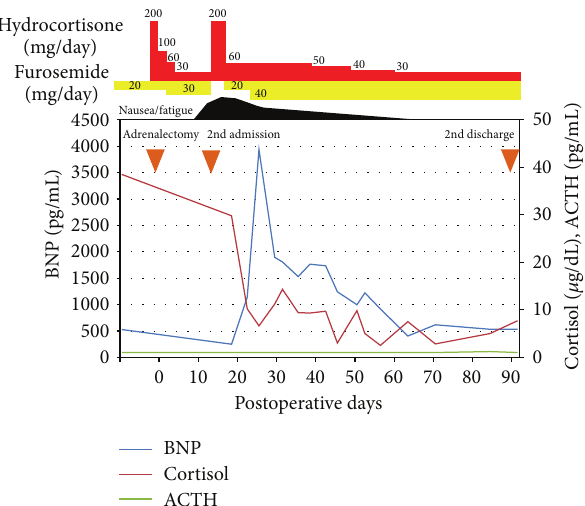
Figure2:Clinicalcourseofthepatientaftertheoperation.Thebrain natriuretic peptide (BNP) level (blue line) is shown on the left side. The levels of cortisol (red line) and ACTH (green line) are shown on the right side. The dosages of hydrocortisone and furosemide are demonstrated on the upper